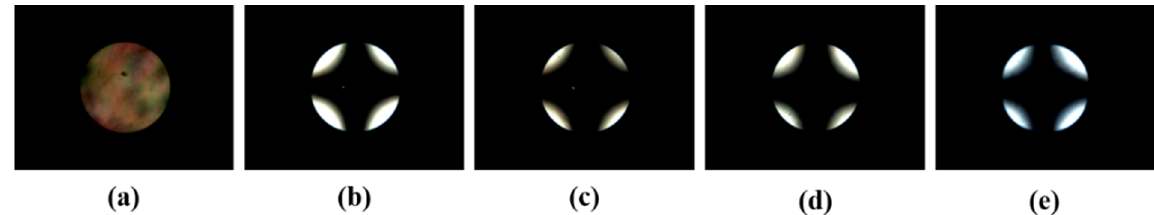
Figure 4. Conoscopic polarized optical microscopy images of the liquid crystal (LC) cells fabricated with PIEU100 films under the following weight ratios of PIEU100: ( a ) 0.001, ( b ) 0.01, ( c ) 0.05, ( d ) 0.1, and ( e ) 1.0 wt.%.